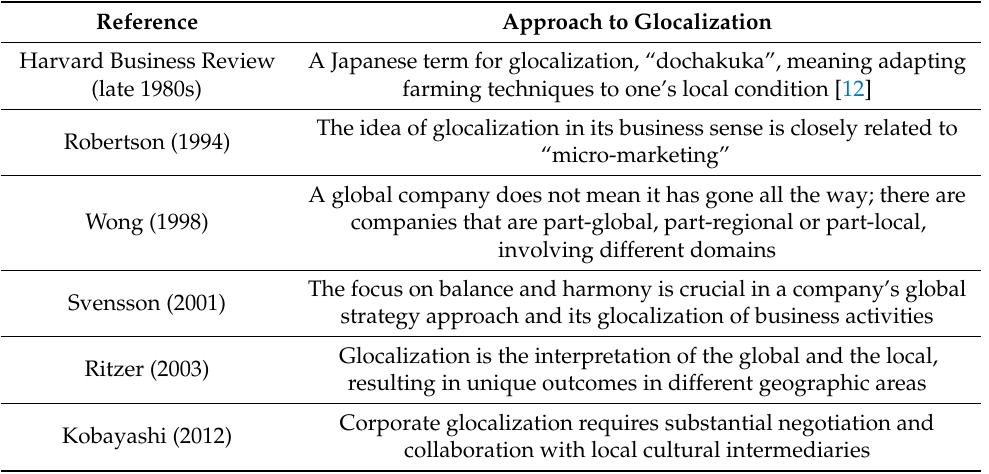
Table 1. Main Approaches to